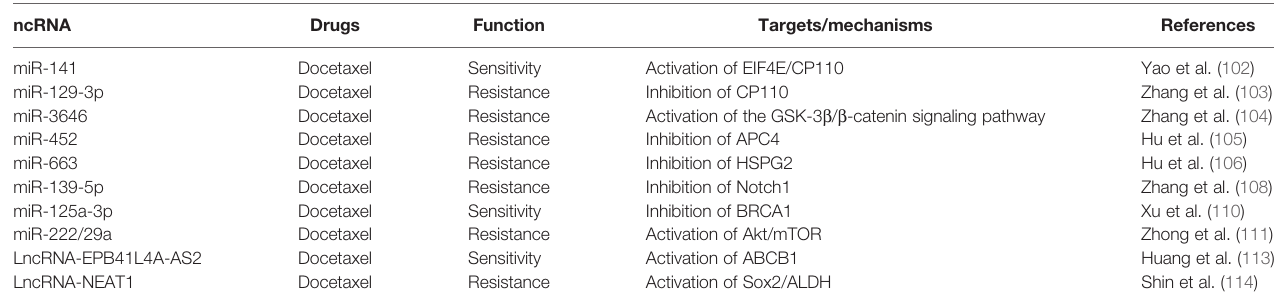
TABLE 4 | Breast cancer docetaxel chemoresistance-related